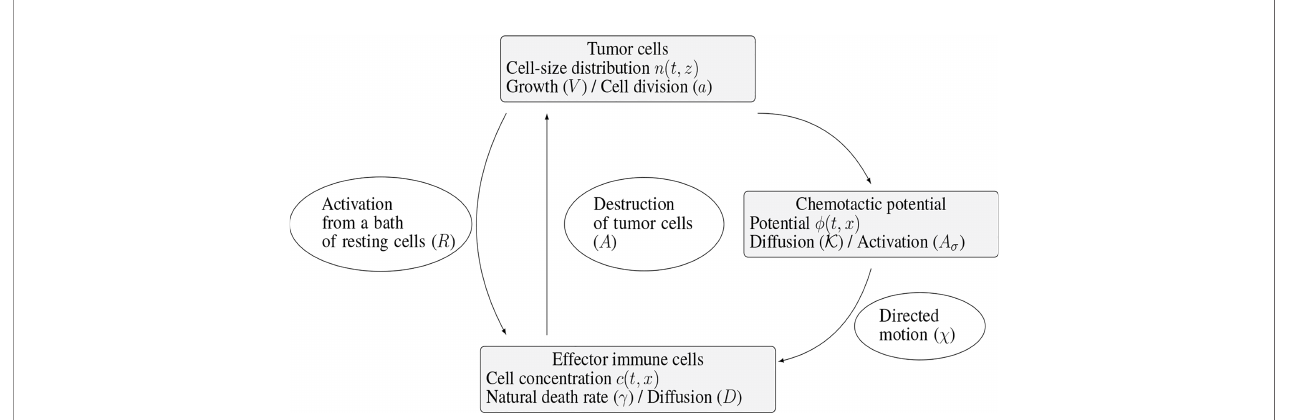
FIGURE 2 | Schematic view of the interaction mechanisms described by the system